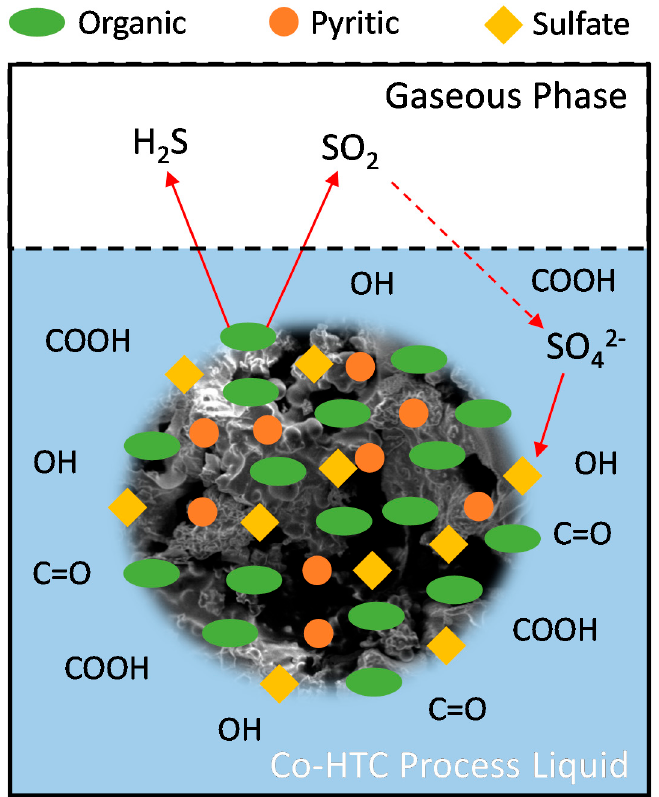
Figure 3. Proposed sulfur transformation mechanism during the Co-HTC of FW and CW.